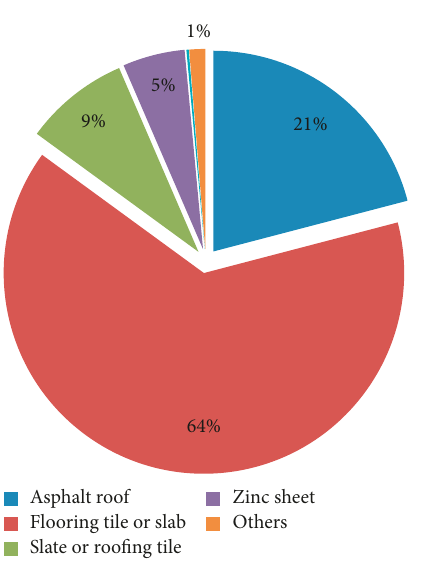
Figure 1: Comparative graphic of the types of house cover used in the province of C´ordoba, Argentina